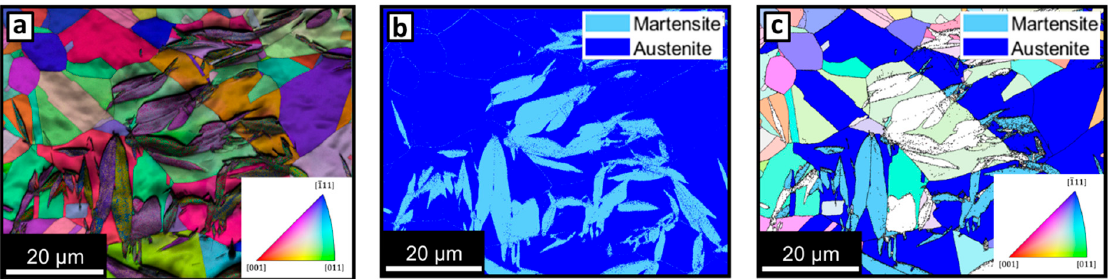
Figure 3. ( a ) EBSD map of FeNiC revealing the orientation data ( b ) phase map showing marten- site/austenite grains, respectively and ( c ) combined EBSD/Phase map revealing both the analysed, selected austenite grains with the corresponding martensite grains in terms of their OR and the remaining unexamined grains according to their